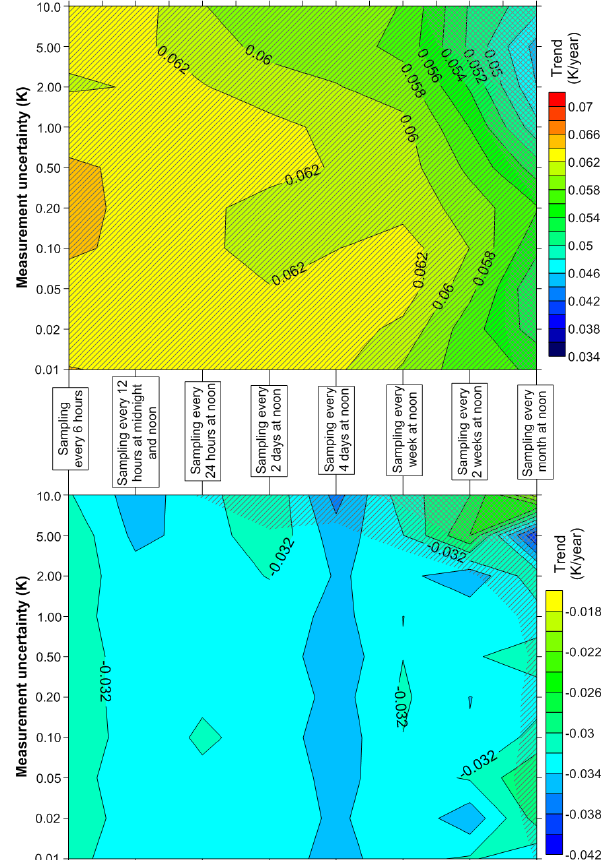
Figure 5. Upper panel: annual mean trends at 1hPa, 85 ◦ N, 135 ◦ W, as a function of individual measurement uncertainty used to cal- culate the monthly means used as input to the regression analysis, and sampling frequency. Regions with single hatching show where trends are statistically significantly different from zero at between 1 σ and 2 σ . Regions with double hatching show where the trend is not statistically significantly different from zero at 1 σ . Lower panel: same analysis as upper panel but for 39.95 ◦ N, 105.2 ◦ W, at